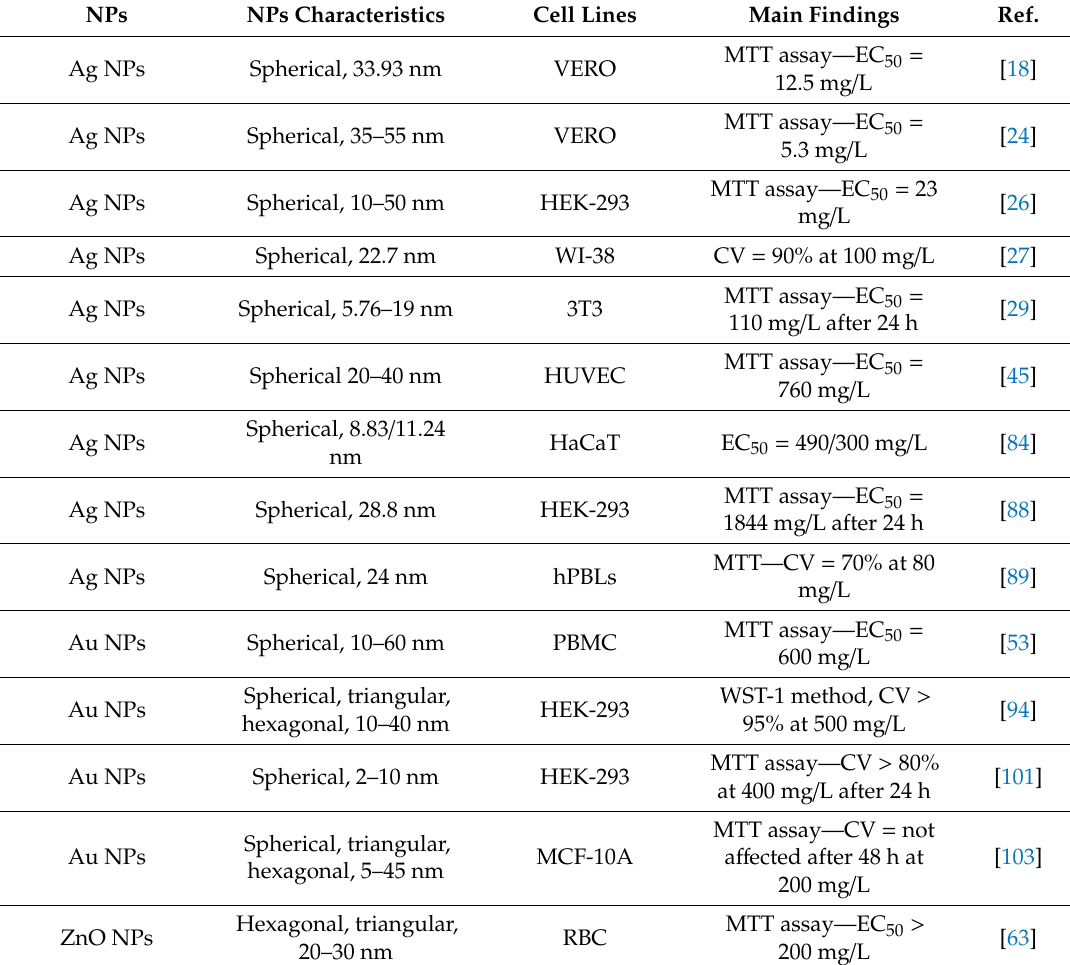
Table 5. Biocompatibility studies regarding phytosynthesized nanoparticles (as presented in studies published in